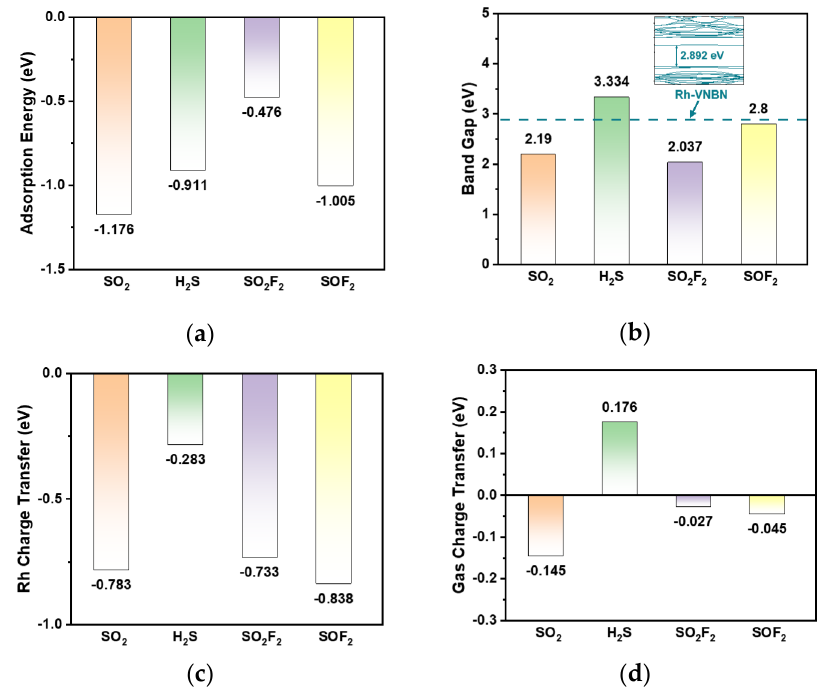
Figure 5. Adsorption and sensing properties of the gas/Rh-VNBN adsorption system: ( a ) Ead values of the four gas/Rh-VNBN adsorption systems; ( b ) band gap values of the four gas/Rh-VNBN adsorption systems; ( c ) charge transfer values of the Rh atom in the four gas/Rh-VNBN adsorption systems; ( d ) charge transfer values of the gas molecules in the four gas/Rh-VNBN adsorption systems.